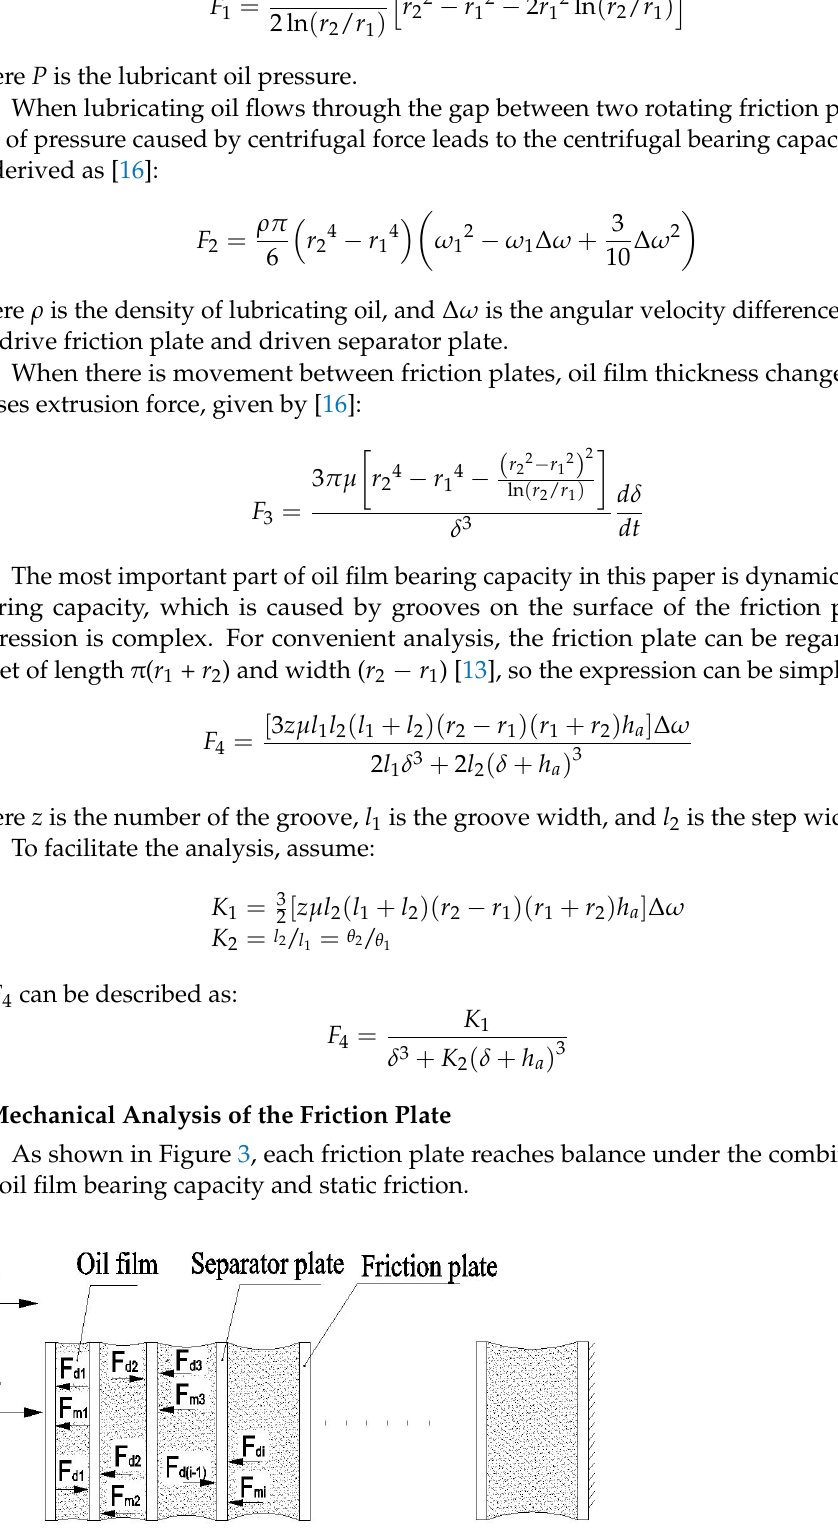
Figure 3. Mechanical model of friction plates.